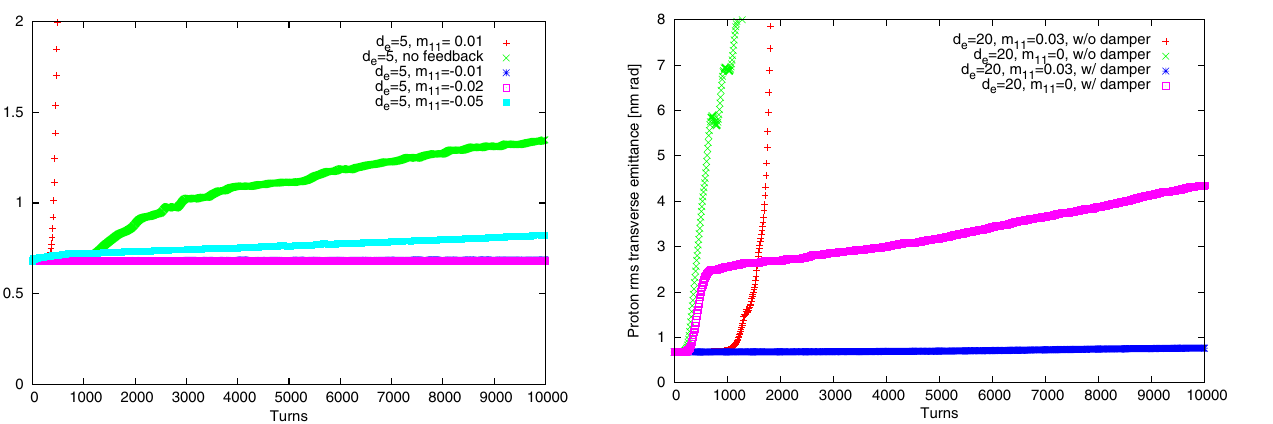
FIG. 8. The effect of the feedback system at disruption parameter